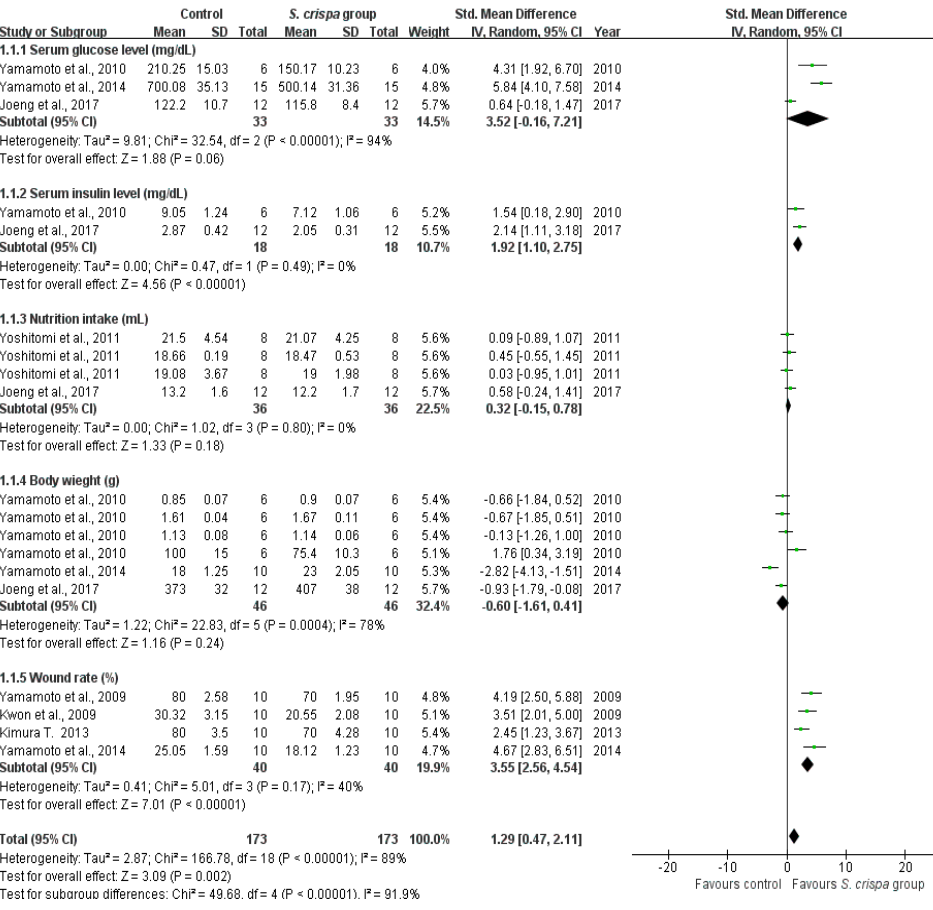
Figure 3. Comparison of diabetic symptoms between control and S. crispa groups. ( ): SMD of individual studies; ( ): summary SMDs of the comparison. Table 3. Summary of standardized mean difference (SMD) comparison between control and S. crispa groups. Medical